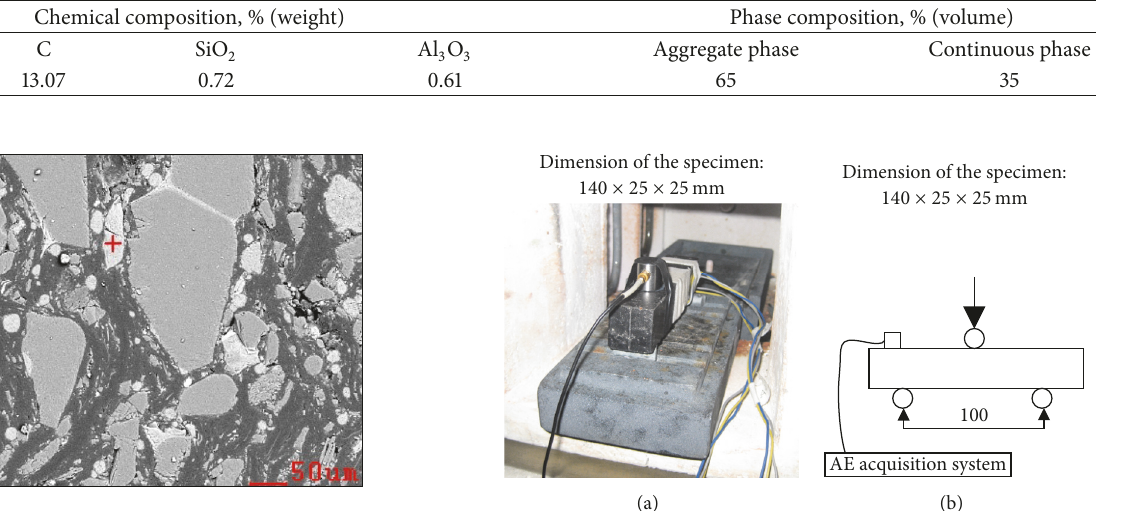
Figure 1: Typical microstructure of magnesia carbon refractory.